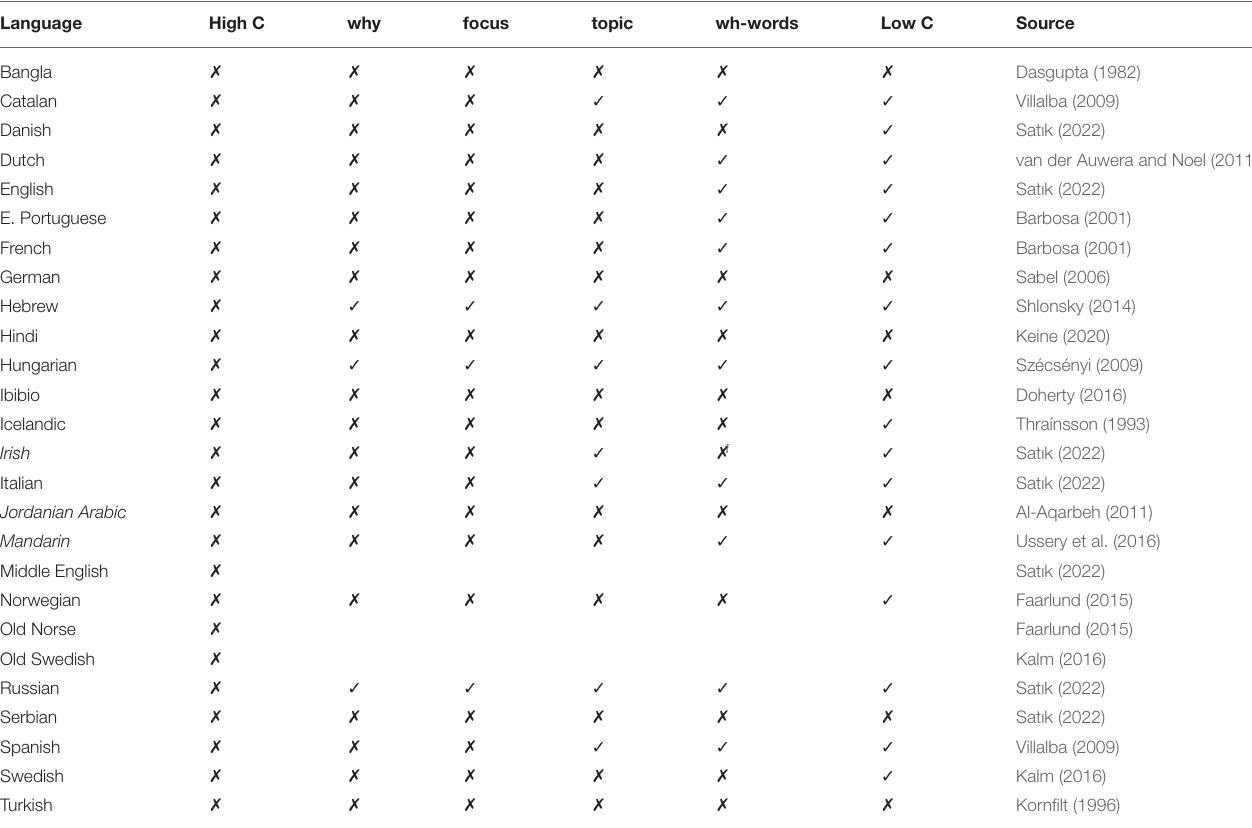
TABLE 1 | The column “High C” is to state whether the language allows a high complementizer in its infinitives or not. Language High